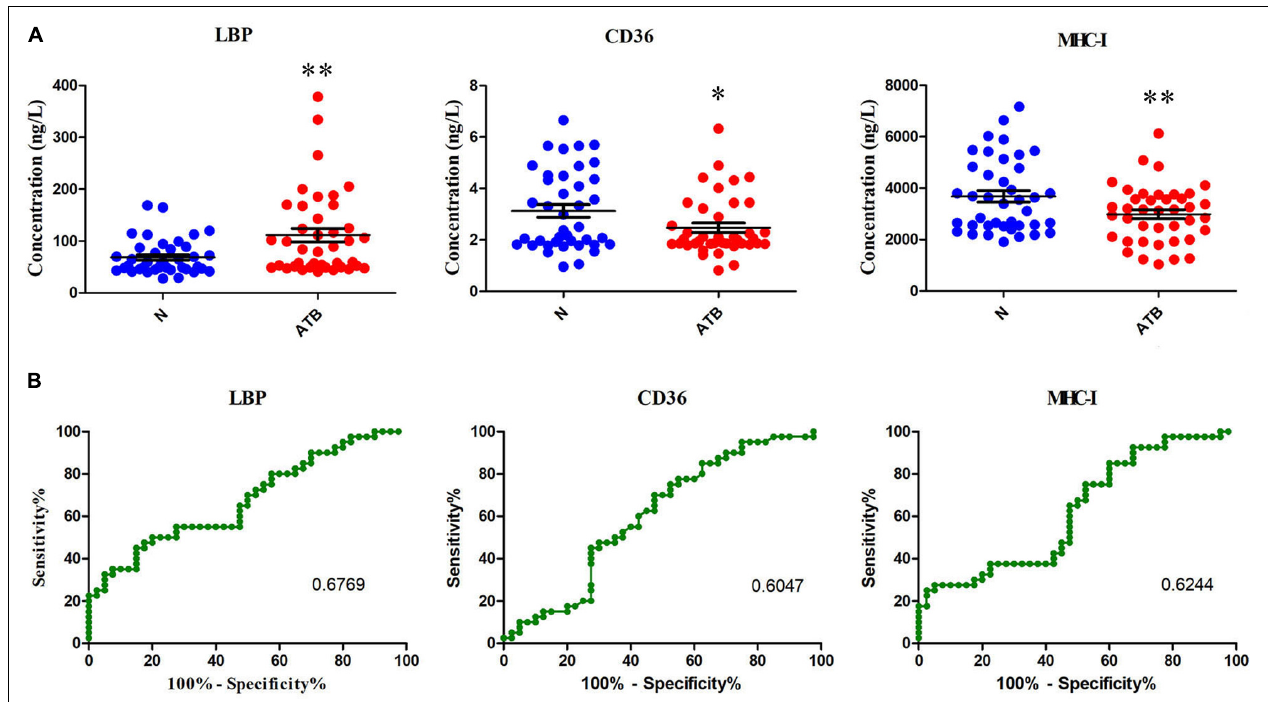
FIGURE 4 | MHC-I, CD36, and LBP expression in the serum of normal individuals and patients with ATB detected using ELISA kits. (A) Concentrations of MHC-I, CD36, and LBP in the serum were analyzed. (B) MHC-I, CD36, and LBP in the serum to distinguish patients with ATB infection from healthy controls. The AUC values of MHC-I, CD36, and LBP were 62.44, 60.47, and 67.69%, indicating that they can be used to distinguish patients with ATB infection from healthy controls (ROC, receiver operating characteristic). * p < 0.05, ** p <